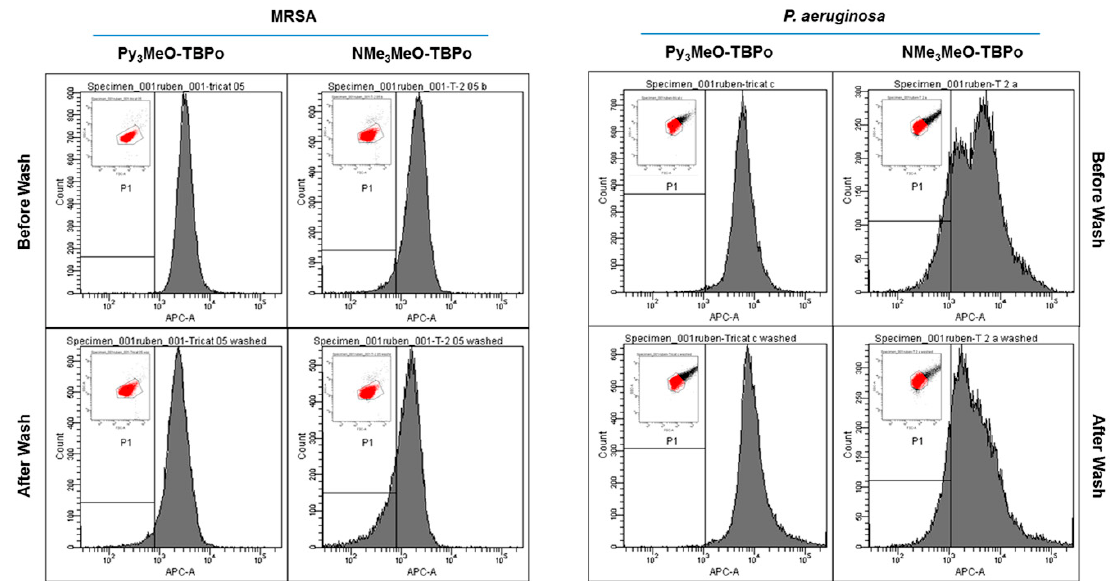
Figure 6. Flow cytometry analysis of bacterial cultures incubated with either 1 or 2 against MRSA ( left panels ) or P. aeruginosa ( right panels ). Cell fluorescence measured in the optimum conditions with or without removing the PS excess. Inset: density plots and ROI of the gated bacteria.